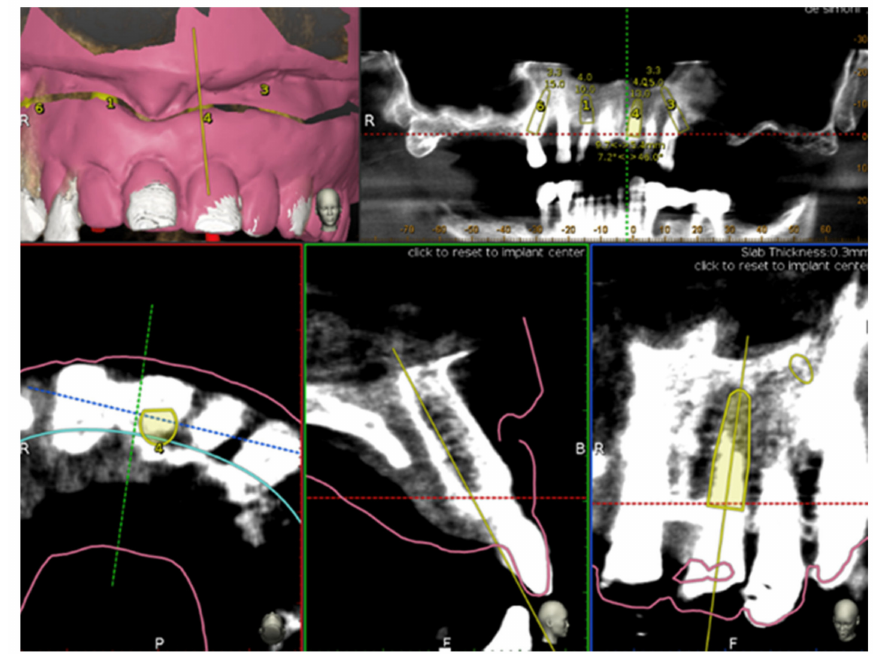
Figure 1. Implant planning by using stereolithography (STL) file as reference for a prosthetic driven implantation.